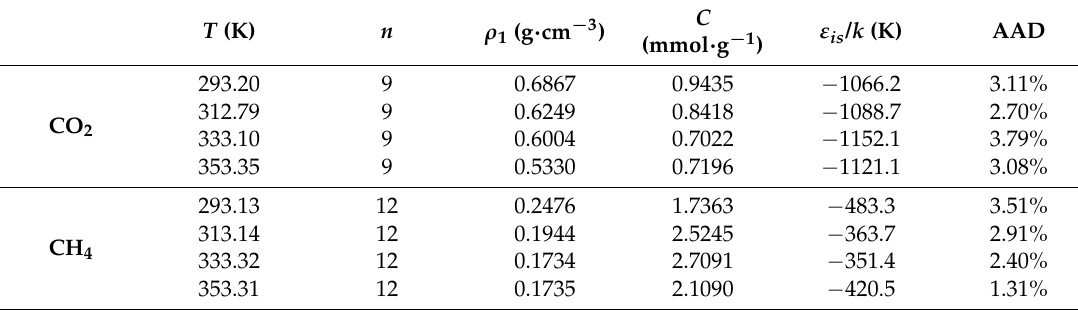
Table 5. Parameters and tolerance analysis of the Ono–Kondo lattice